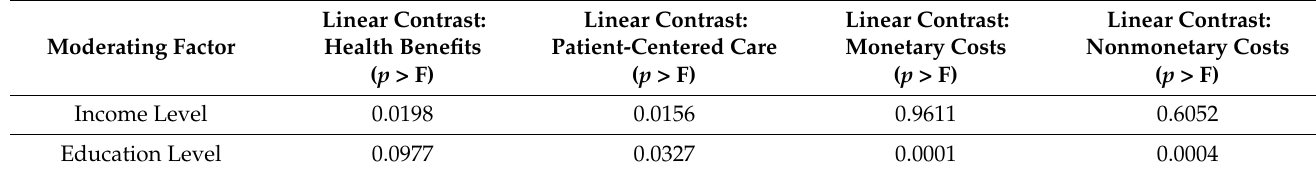
Table 3. Linear Contrast Results for Dimensions of Patient Satisfaction.